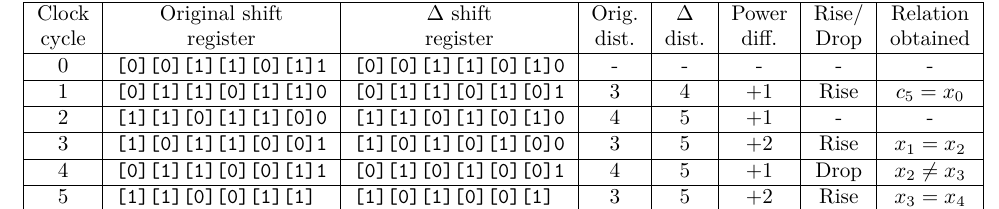
Table 4: Toy shift register example: Power consumption difference and bit relations obtained. Second and third columns are the register state of the original and with some difference, “Orig. dist.” and “∆ dist.” indicates the Hamming distance between the previous and current state, “Power diff.” indicates the numerical power consumption differences, “Rise/Drop” is the observation of the power consumption difference at the rising edge of the clock, and last column is the bit relation